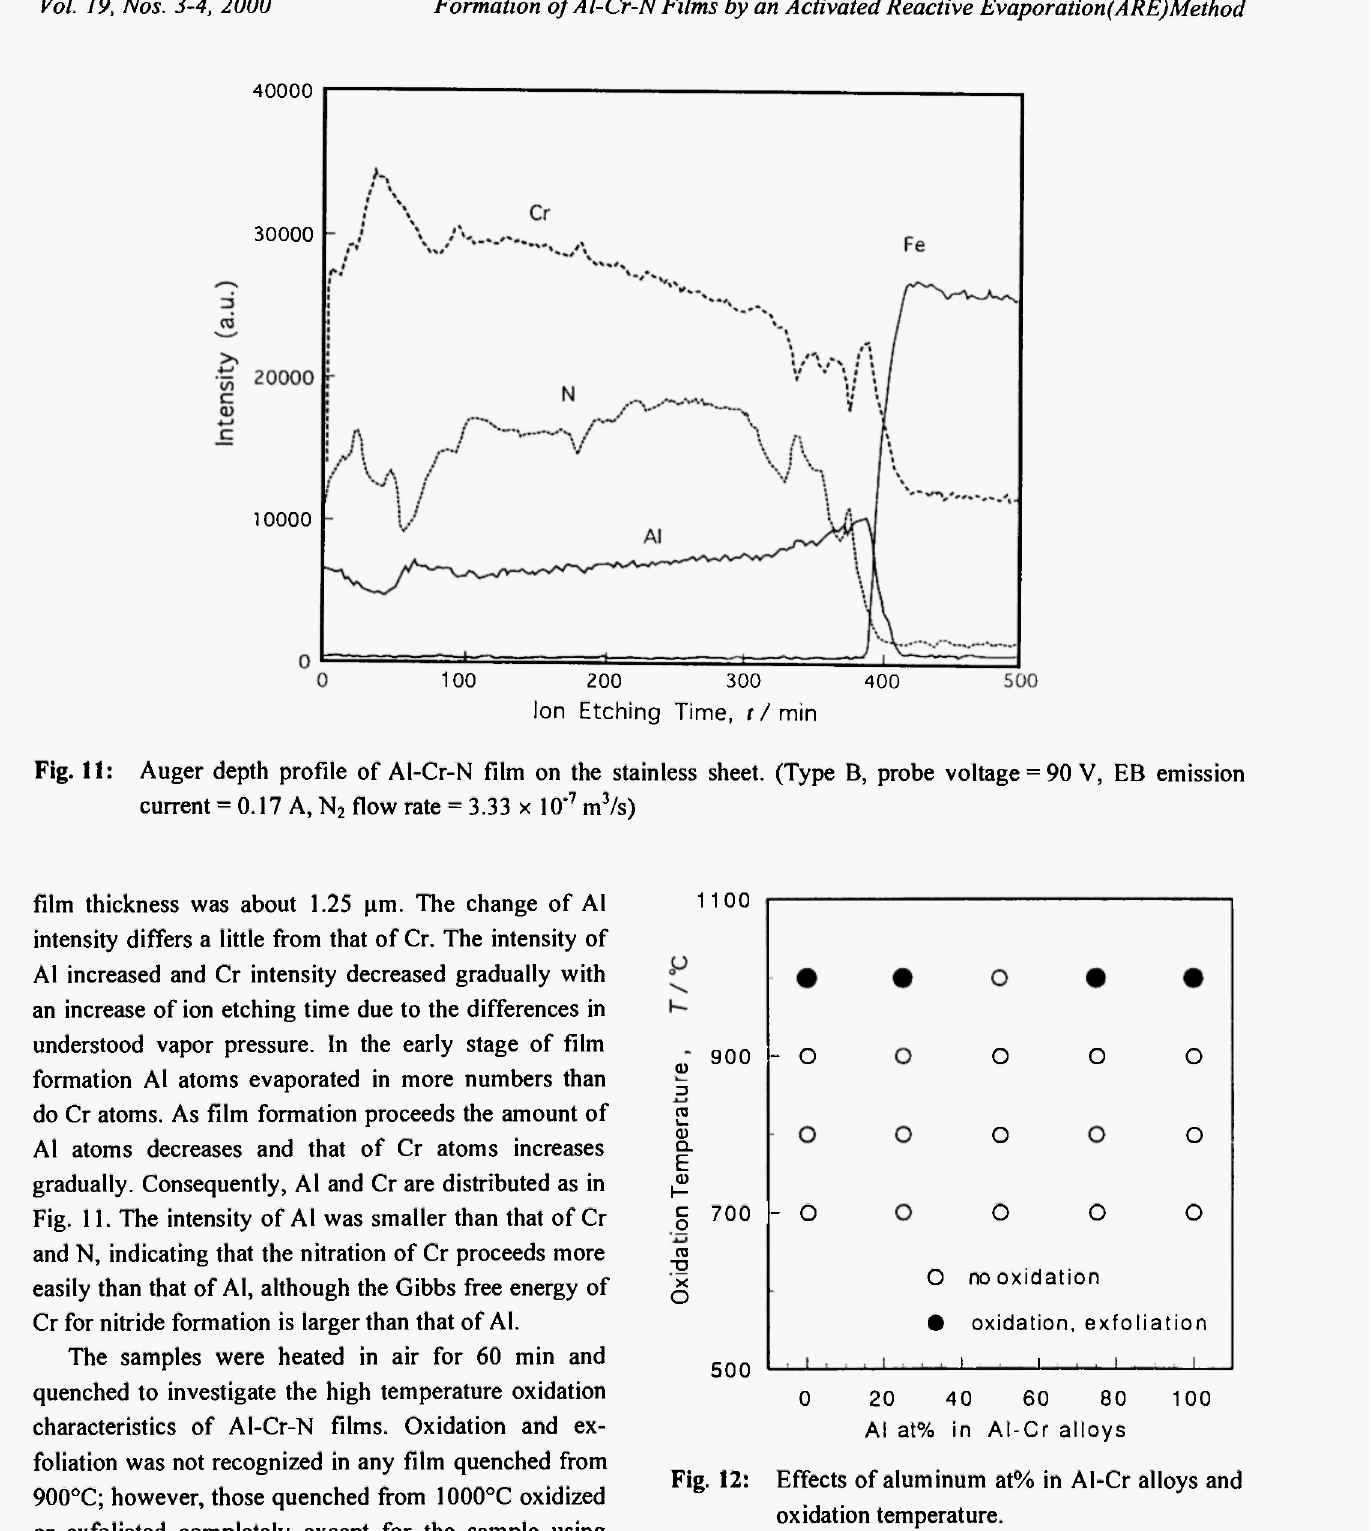
oxidation temperature.